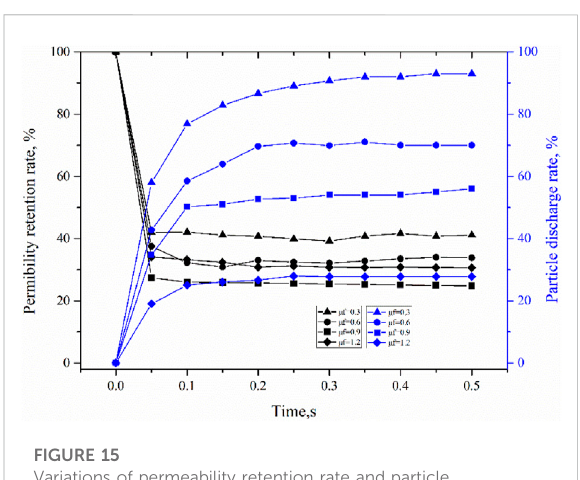
FIGURE 15 Variations of permeability retention rate and particle discharge rate of JRC 15 plugged with particles of different friction coef fi